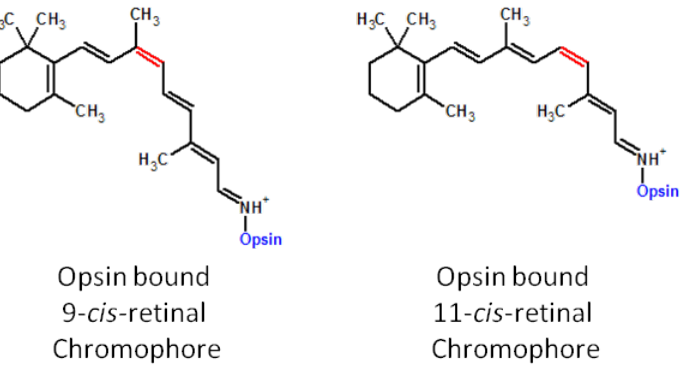
Figure 4. Isomers of the opsin chromophore. Both 11- cis -retinal and 9- cis -retinal form a Schiff base with residue K296 of the opsin molecule forming the light sensitive chromophore used in